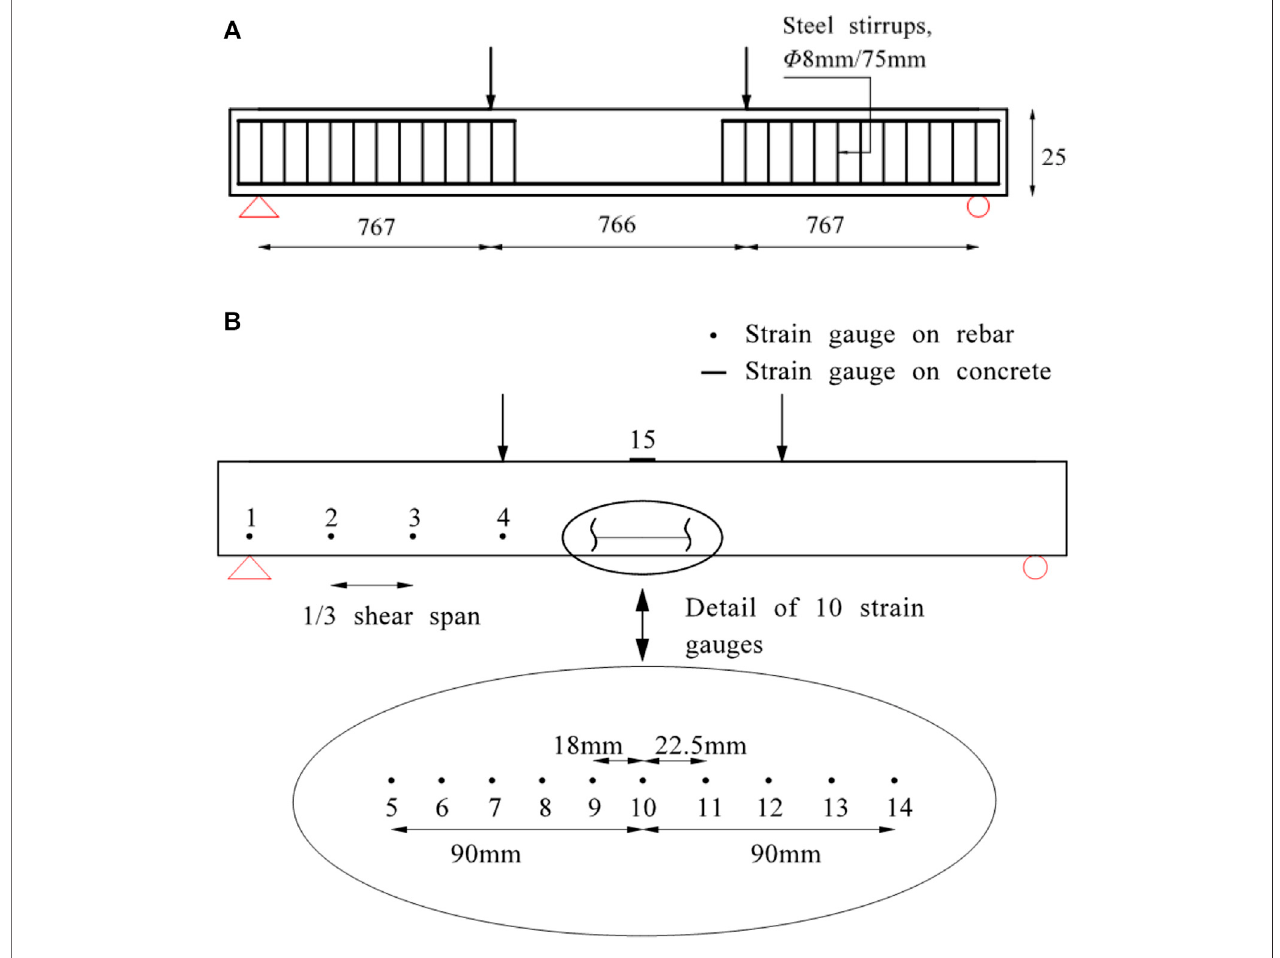
FIGURE 3 | (A) Experimental test setup, (B) arrangement of rebar and concrete strain gauges.